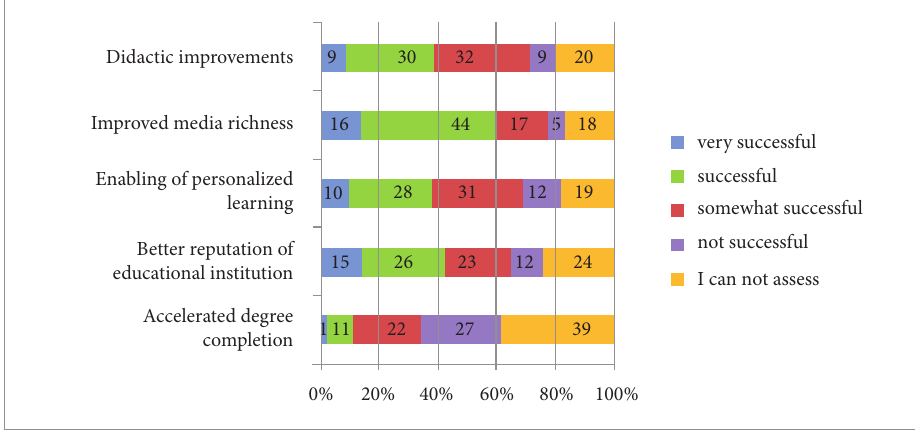
Table 7. Advantages of blended learning in higher education